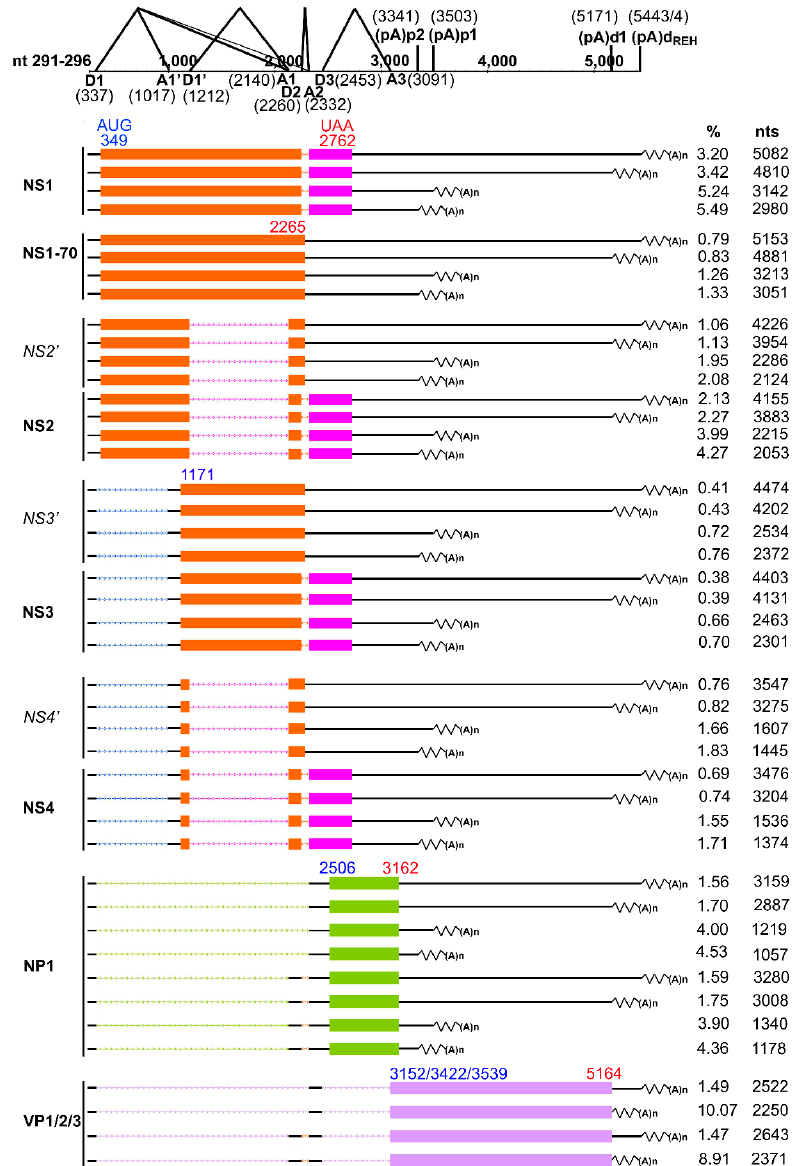
Figure 4. Analyses of all HBoV1 mRNA transcripts based on mRNA-seq data. HBoV1 genome is schematically diagramed with identified donor and acceptor sites, as well as the identified (pA)p1, (pA)p2, (pA)d1 and (pA)d REH polyadenylation sites, used during virus infection. Assembled transcripts of NS1, NS1-70, NS2, NS3, NS4, NP1, and VP using alternative splicing sites and alternative polyadenylation sites [(pA)p1, (pA)p2, (pA)d1 and (pA)d REH ] are diagramed. Percentage (%)